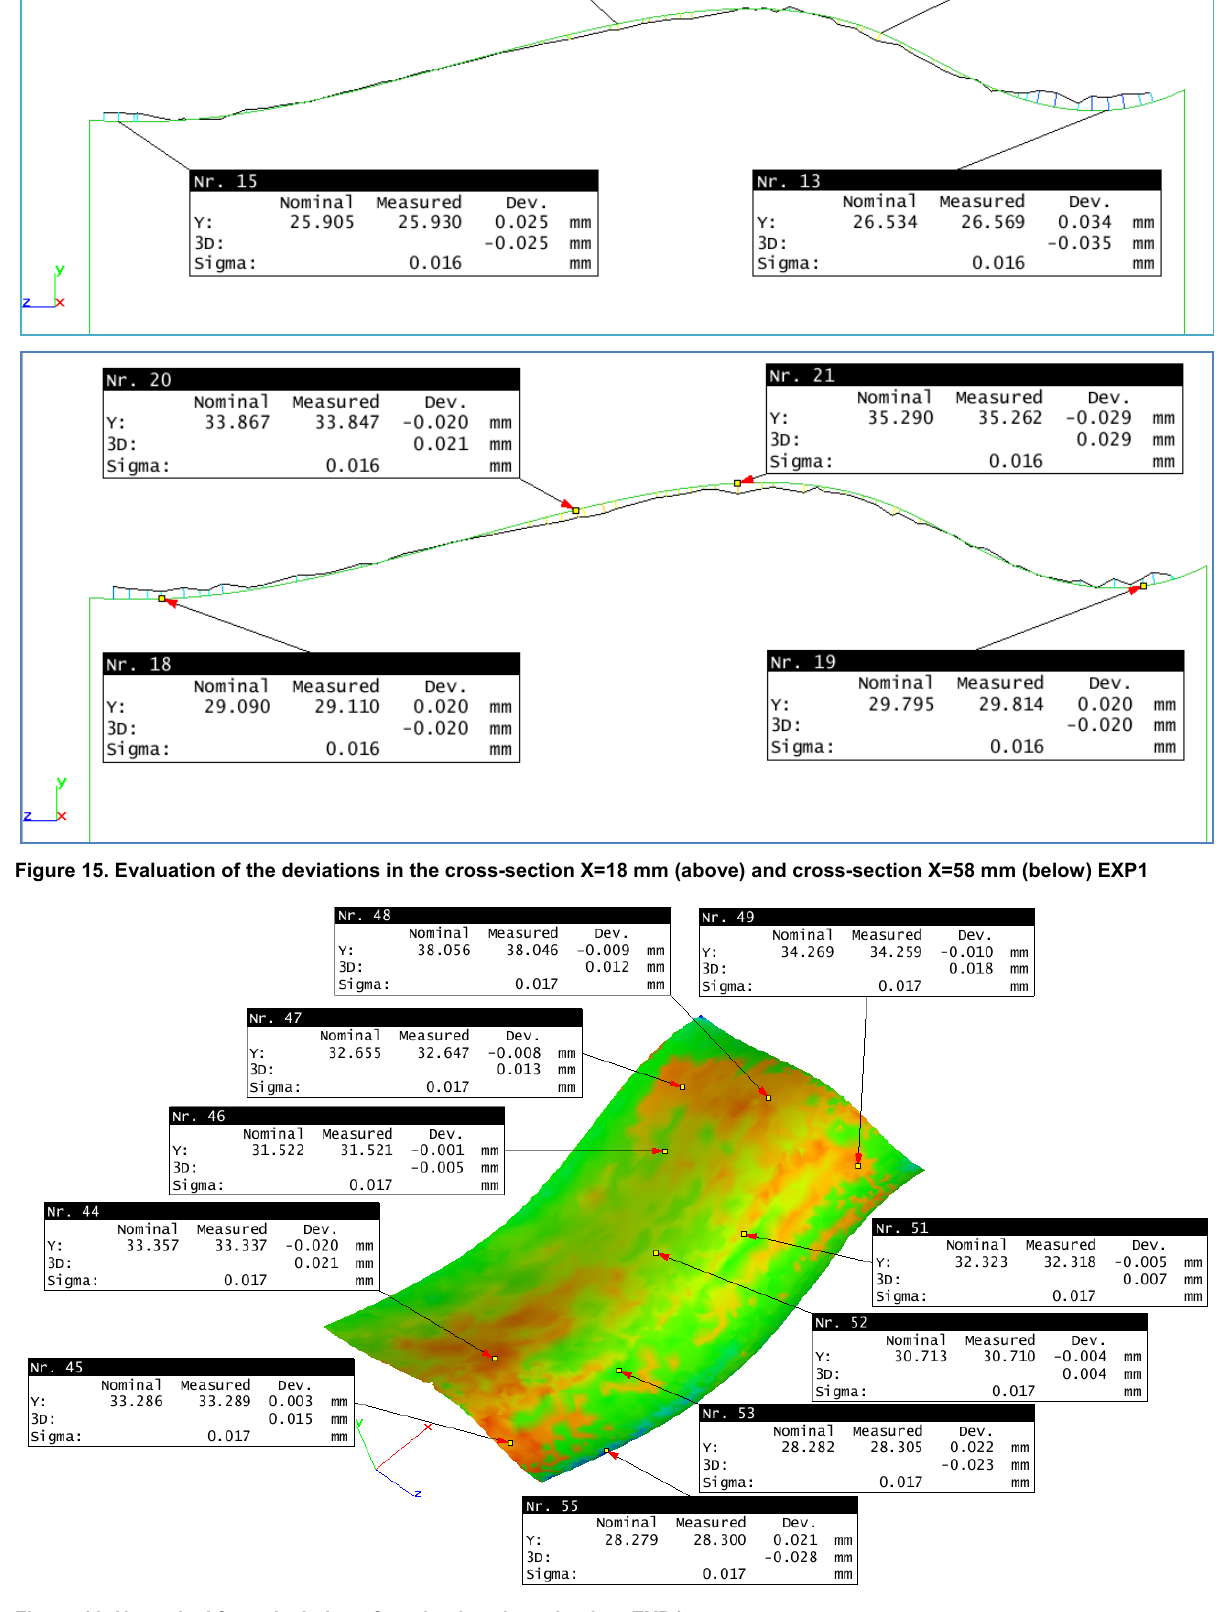
Figure 16. Numerical form deviation of randomly selected points